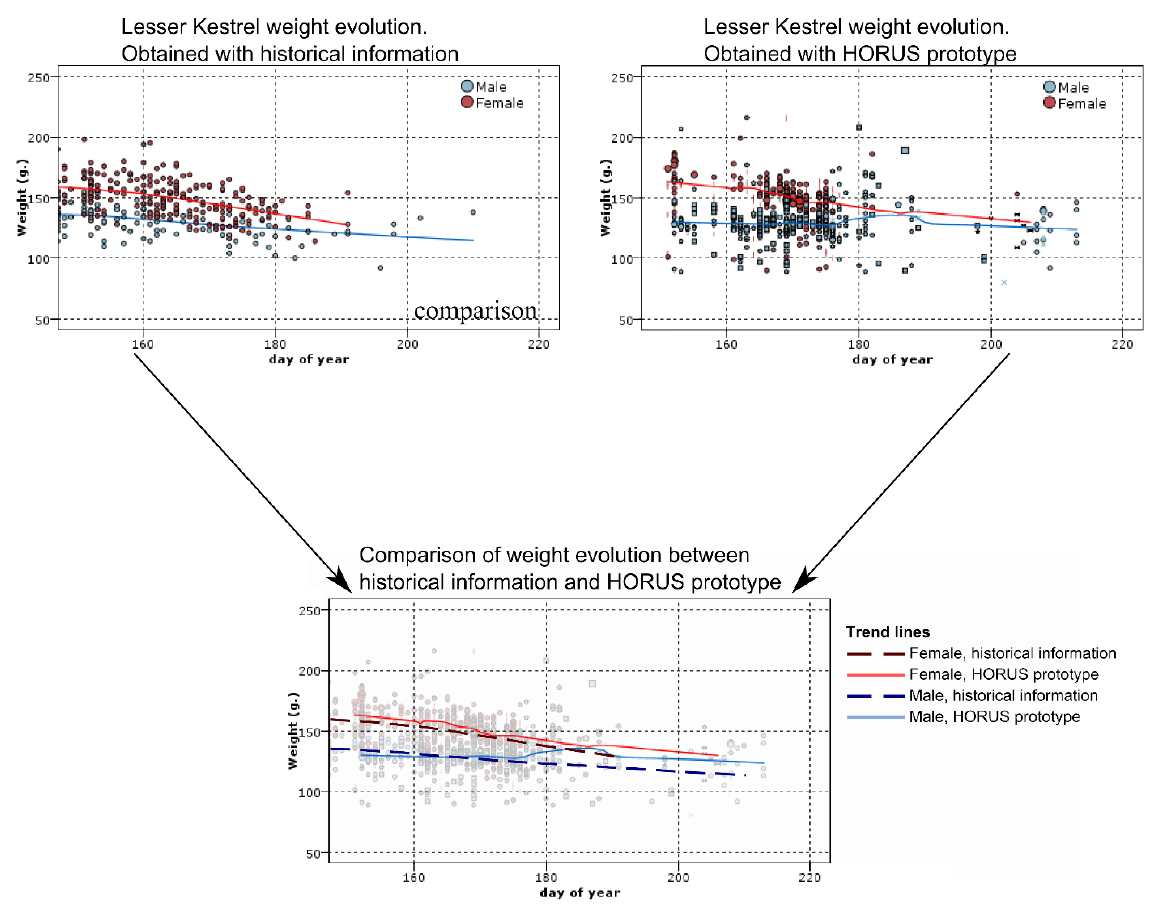
Figure 9. Weight evolution obtained on the basis of manual measurements along several years of monitoring. Each point represents a single measurement of an